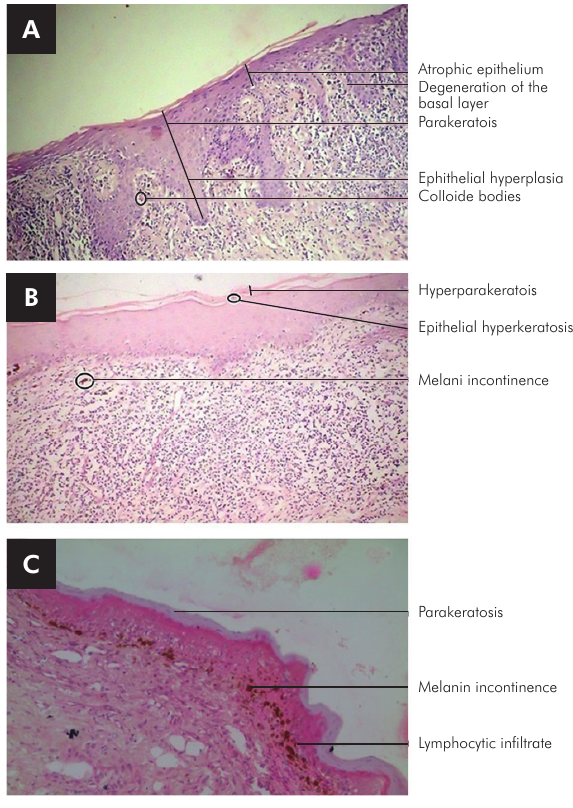
Figure 1. Histological features: (A) In reticular oral lichen planus, parakeratinized stratified squamous epithelium is in association with inflamed fibrovascular connective tissue, the epithelium is atrophic in few foci exhibiting basal cell degeneration, connective tissue shows sub-epithelial band of chronic inflammatory cell infiltrate. (B) In untreated erosive oral lichen planus, hyperparakeratinized stratified squamous epithelium is in association with inflamed fibrovascular connective tissue, the epithelium is atrophic and exhibits basal cell degeneration, the connective tissue shows sub-epithelial band of chronic inflammatory cell infiltrate. (C) In treated erosive oral lichen planus, the epithelium is parakeratinized and exhibits basal cell degeneration, inflammatory lymphocyte infiltration and melanin